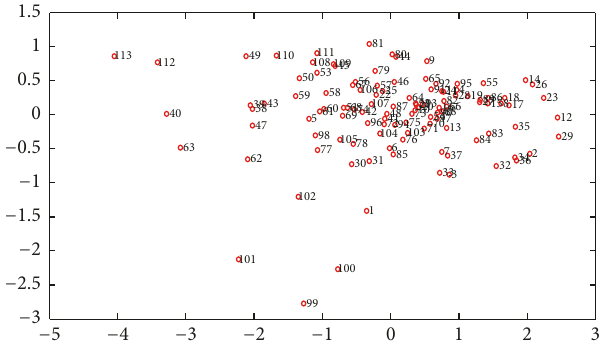
Figure 2: Investigation of dataset cluster trends by using PCA scores.